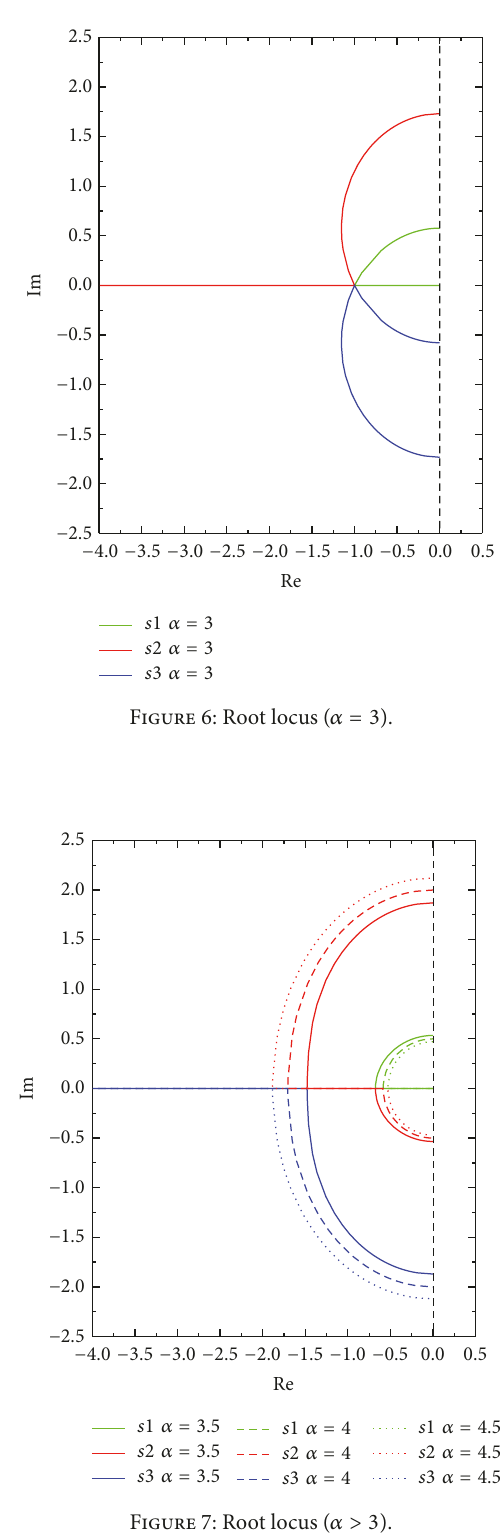
Figure 7: Root locus ( 𝛼 > 3